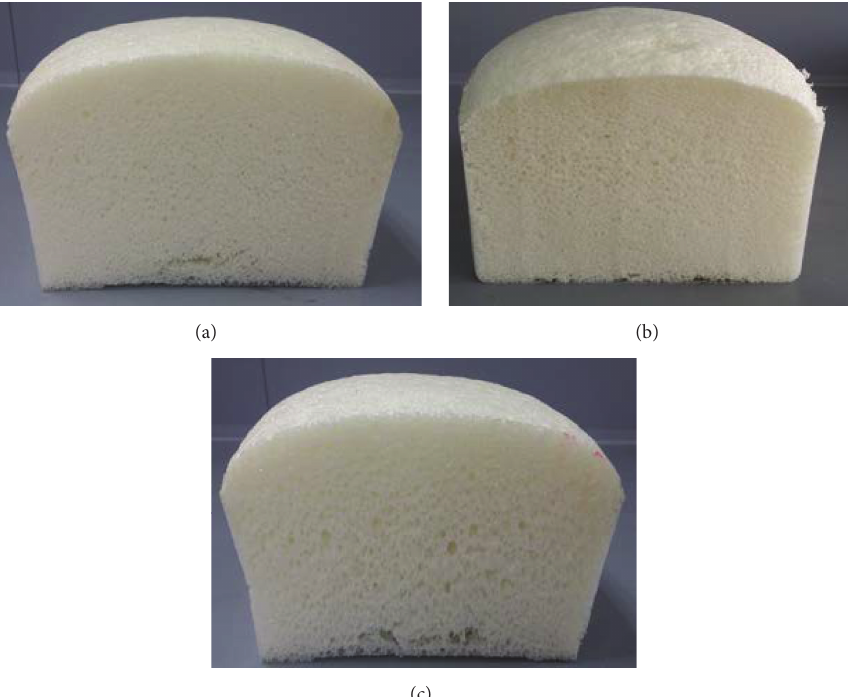
Figure 4: PU bionanocomposite foams prepared from 20% Pioneer E-135 with incorporation of (a) 3 wt% OMMT, (b) 5 wt% OMMT, and (c) 7 wt% OMMT.